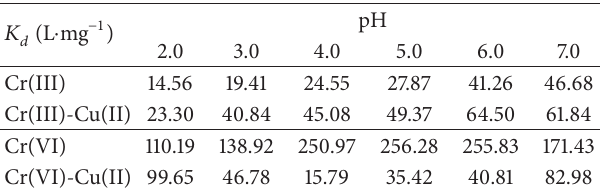
Table 5: 𝐾 𝑑 value of Cu(II) on Cr(III) and Cr(VI) adsorption onto kaolin under different pH